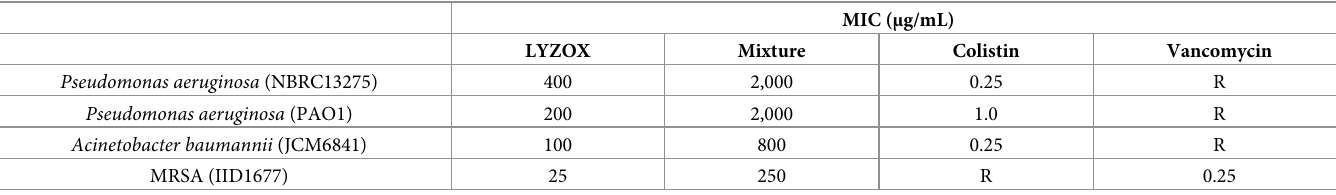
Table 1. Comparison of the minimal inhibitory concentrations.